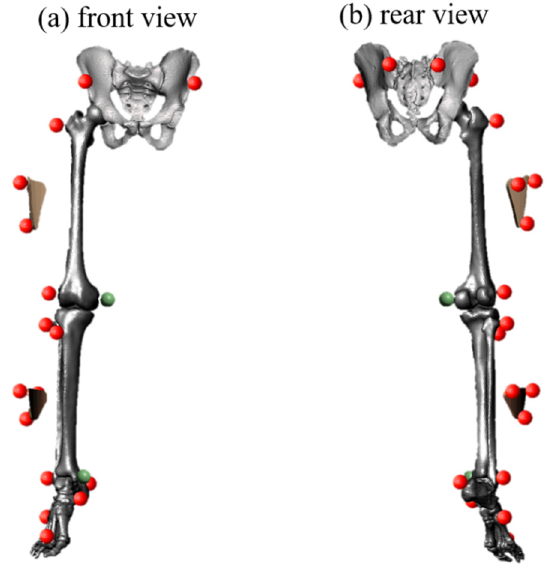
Figure 4. ( a ) Frontal view and ( b ) rear view of marker placement. The green markers would be removed during dynamic trials.